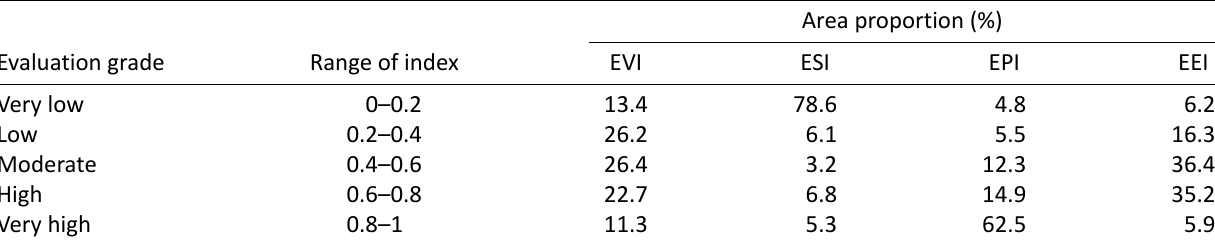
Table 2. The area proportion of the primary and secondary index of urban ecosystem vulnerability in each evaluation grade of Nanjing